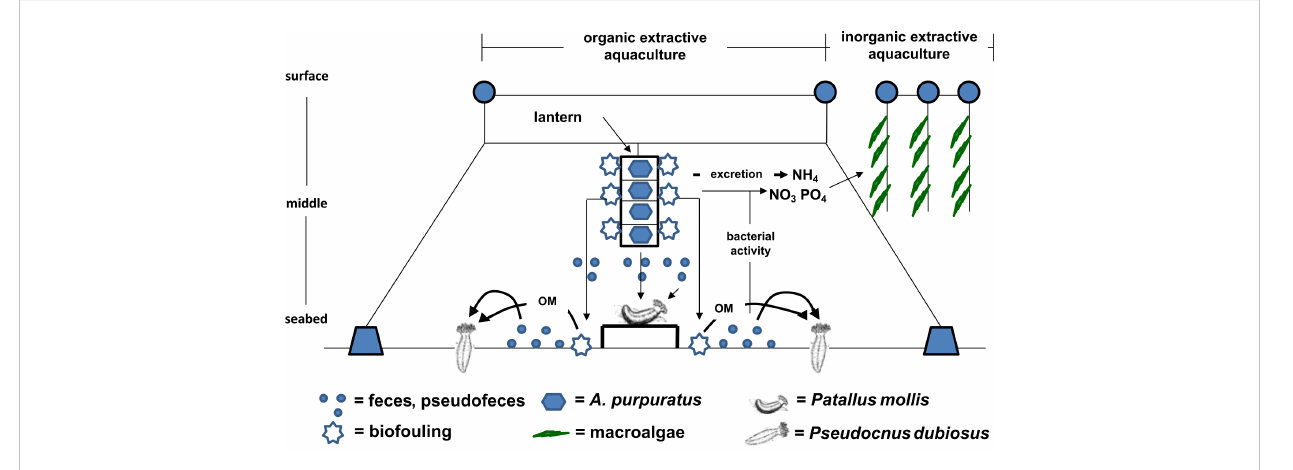
FIGURE 4 Diagram of the IMTA model proposed for experimental assays in Samanco Bay.